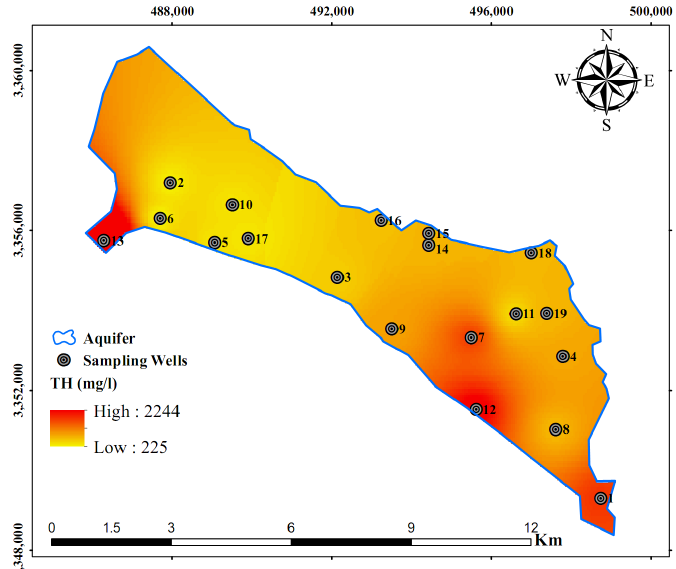
Figure 7. Total hardness (TH) in groundwater samples in study